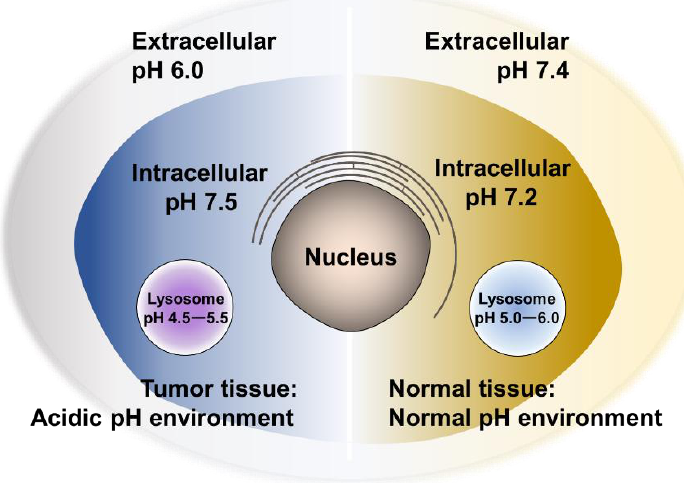
Scheme 1. Schematic illustration of the concept of ( A ) light- or ( B ) pH-responsive drug delivery systems (DDSs); a. photo-isomerization, b. photodynamic responsive DDSs, c.